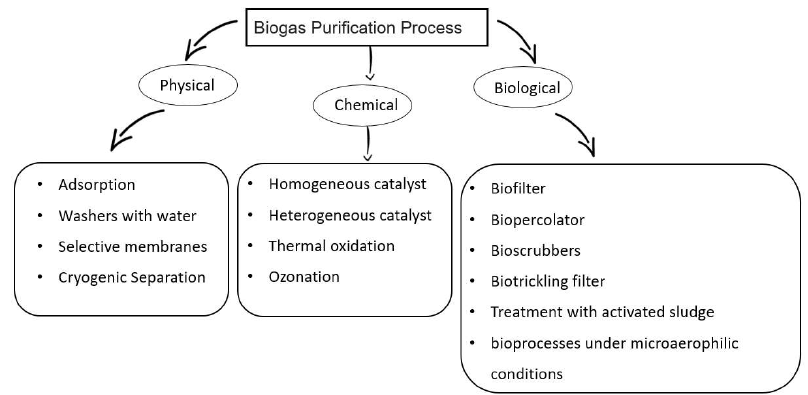
Figure 1. Biogas Purification Process.